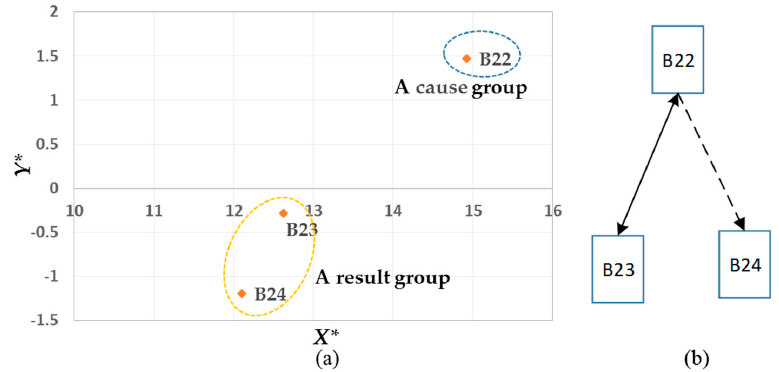
Figure 7. Cause and effect diagrams for the market. ( a ) The causal attributes of the sub-criteria in this group and ( b ) corresponding significant relations.